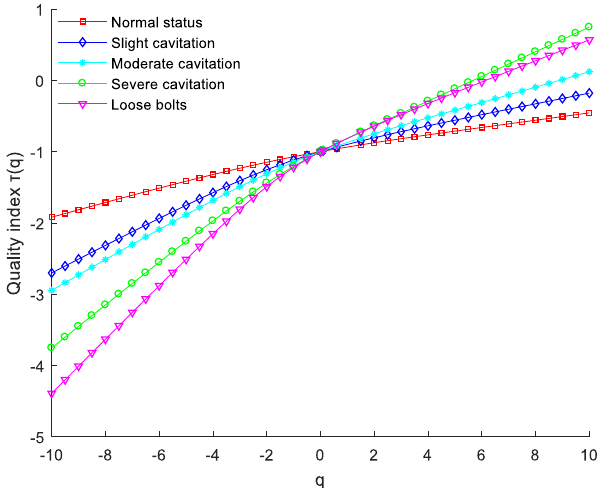
Figure 4. Quality index of centrifugal pump vibration signals.